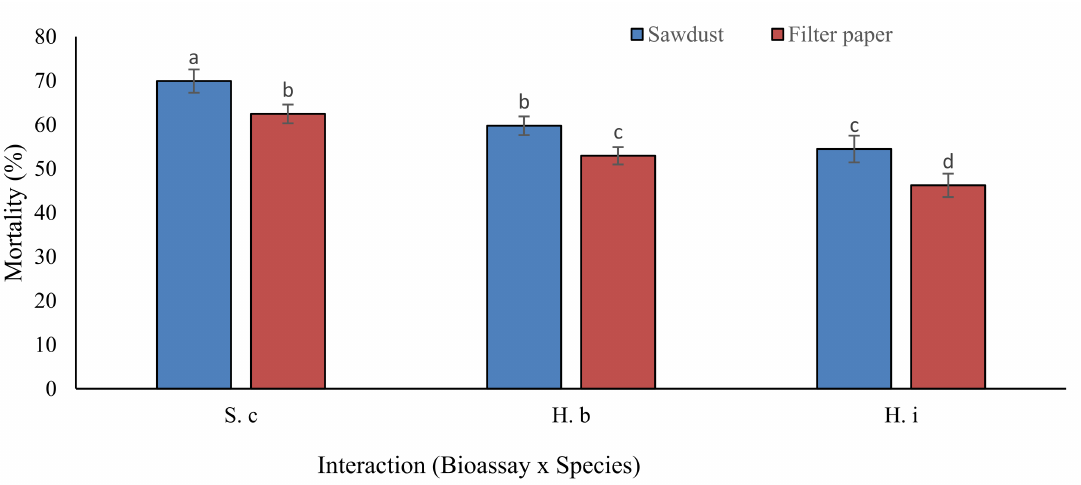
Figure 2. Interactive effect of bioassays × nematode concentrations (B × C) on percentage mortality of Odontotermes obesus workers kept under laboratory conditions (16 ± 1 ◦ C). Bars with different lowercase letters were significantly different at p ≤ 0.05 (LSD test). Vertical bars indicate standard error (SE) values.